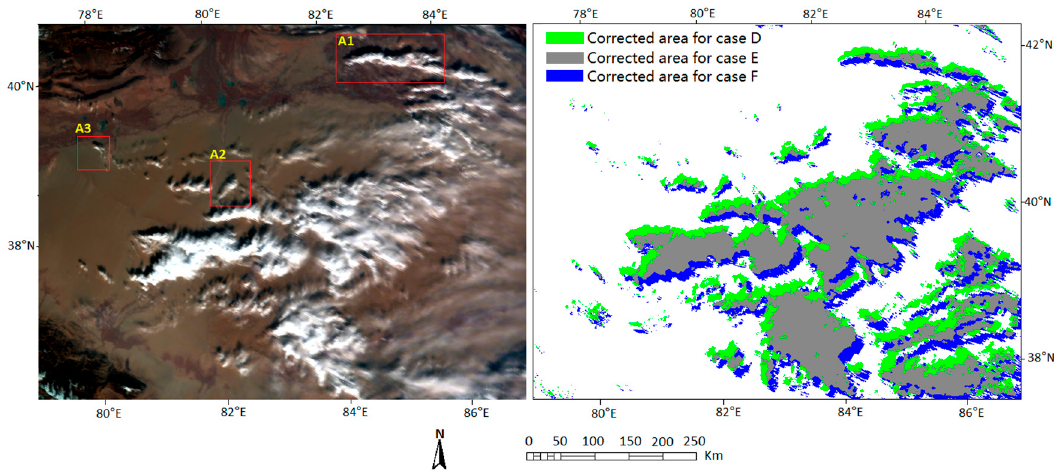
Figure 3. Corrected SWDR regions for the three cases illustrated in Figure 2. (left: MODIS bands 2–4 for R,G,B; right: three cases affected by solar-cloud-sensor geometry, i.e., green: Shadow shown on the image; gray: shadow covered by cloud, and blue: bright surface covered by cloud. A1, A2 and A3 are three subset regions selected for detailed comparison in subsequent analysis).